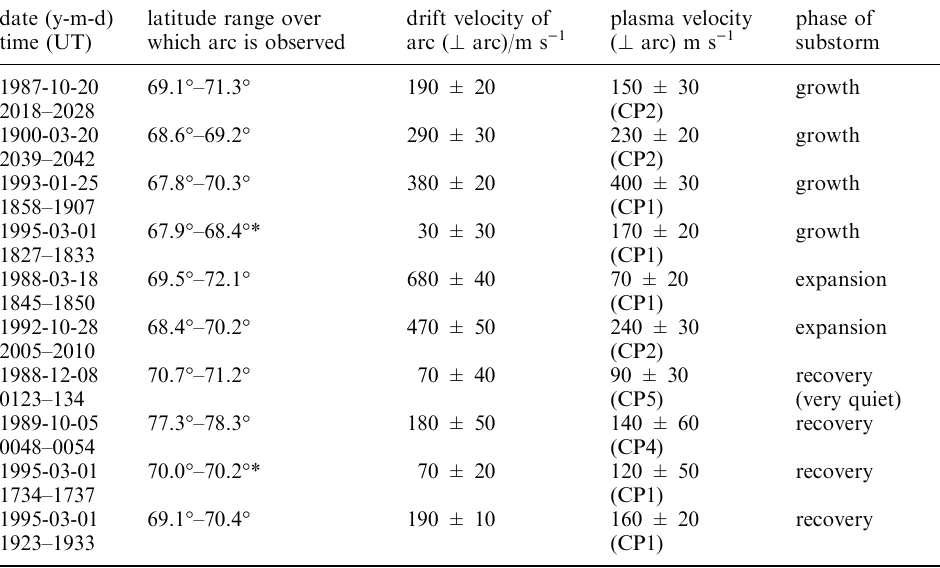
drift velocity of arc ( ? arc)/m s )